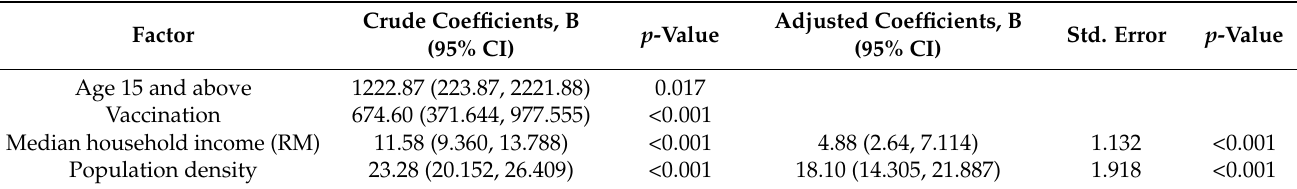
Table 1. Multivariable analysis between COVID-19 cases and sociodemographic factors.